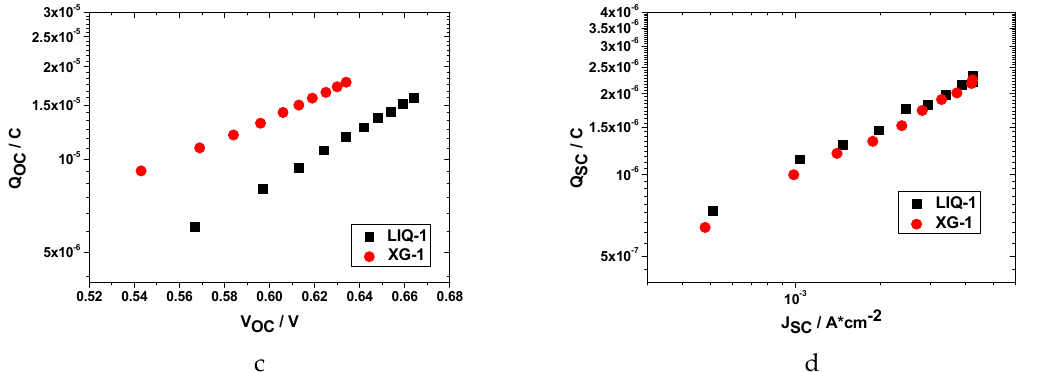
Figure 5. ( a ) Electron lifetime and ( b ) transport time. Extracted charges for aqueous liquid and hydrogel cells as a function of ( c ) V OC and ( d ) J SC under different light intensities.